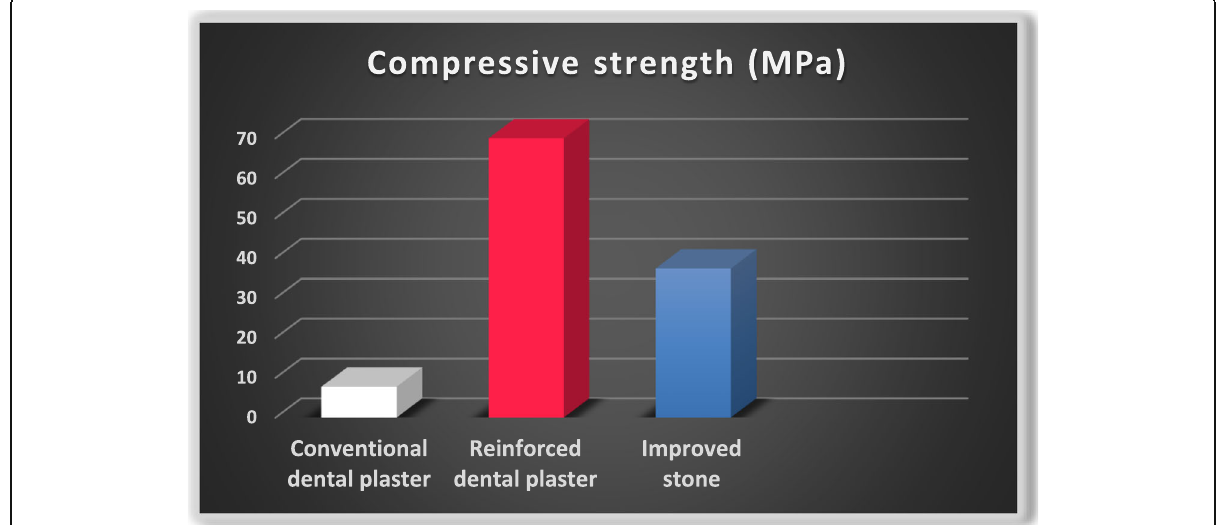
Fig. 5 Histogram illustrating mean compressive strength (MPa) values between the three groups